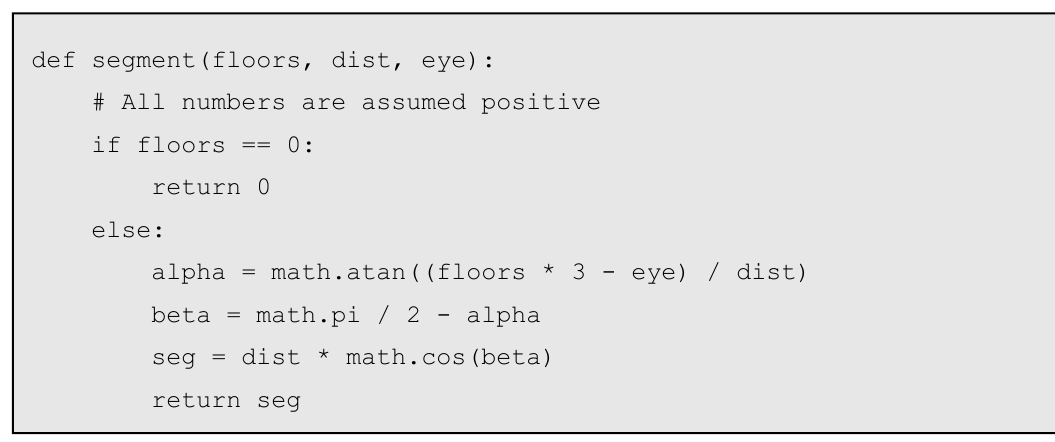
Code 1. Python function to calculate occlusion